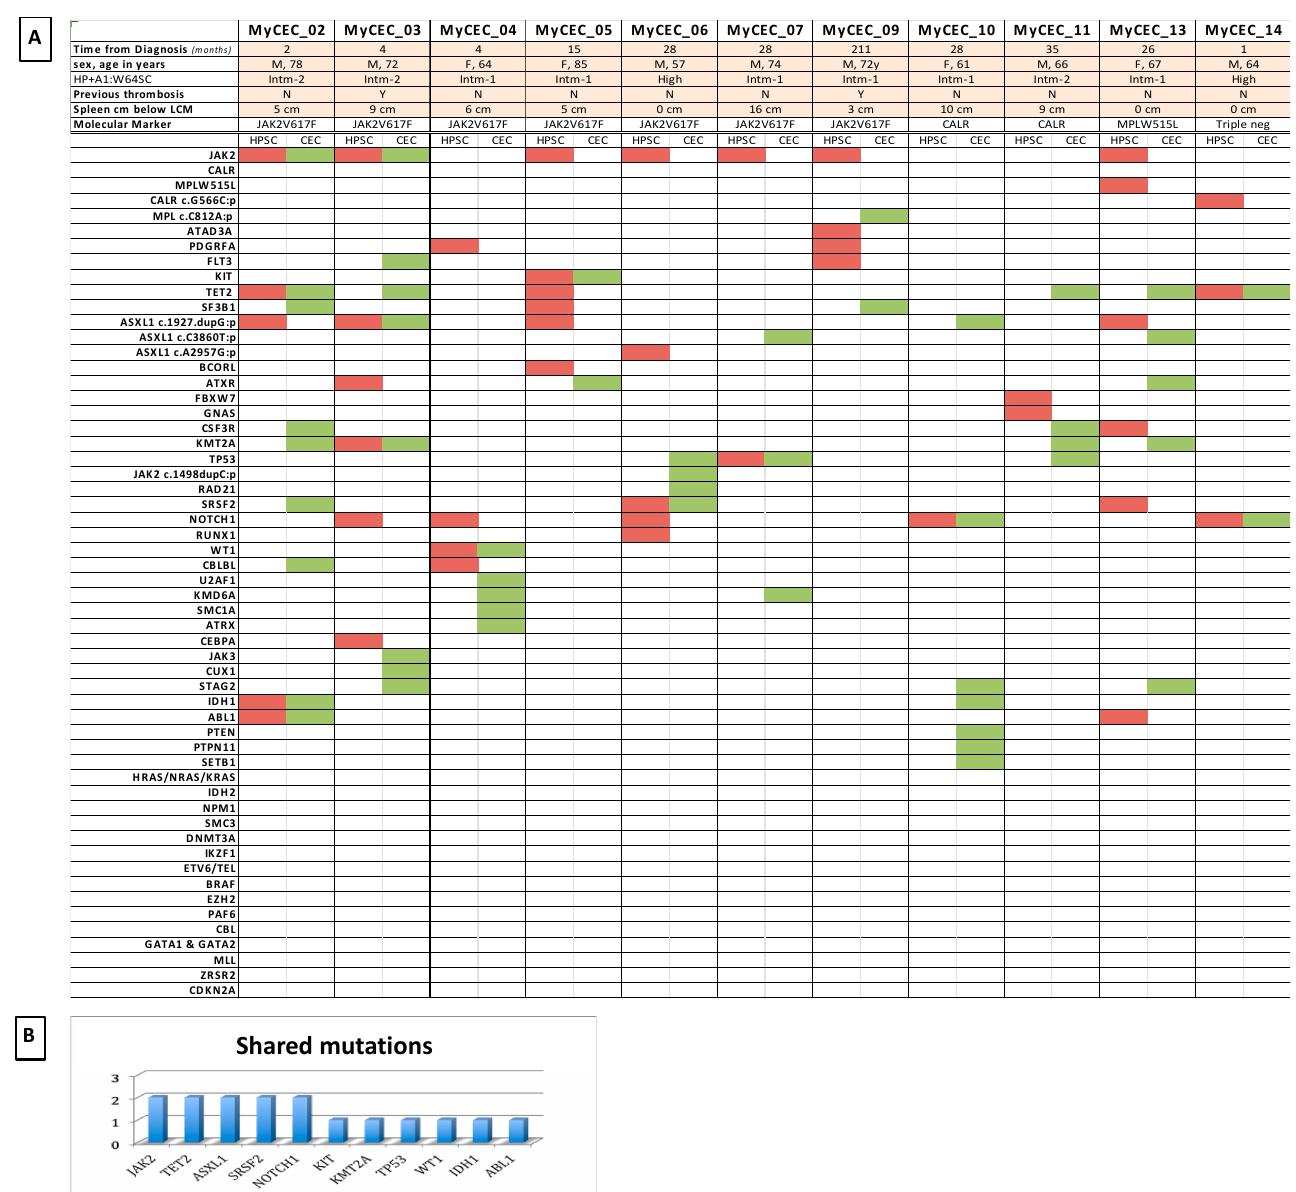
Figure 4. Comparative Somatic profiling of CD34 + -HSPCs and CECs in PMF patients. ( A ) Molecular profiles of both CEC and HSPC in patients with PMF. The molecular lesions found in the HSPC are in red, while in Green the ones discovered in the CEC. At the top of the table the clinical characteristics of patients, who successfully recovered CEC. ( B ) Mutated genes shared between HSPCs and CECs.